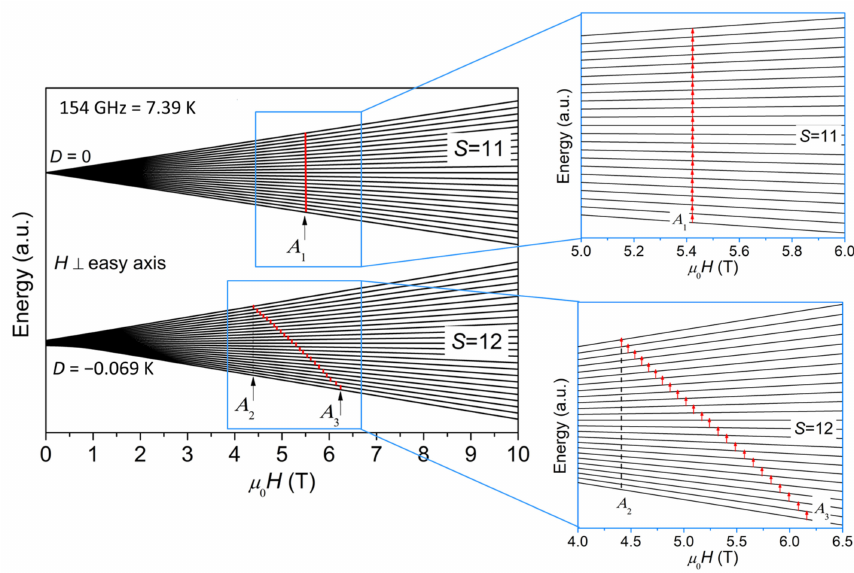
Figure 4. A schematic representation of the energy levels for S = 11 and S = 12 as a function of magnetic field ( H ⊥ easy axis), where A 1 , A 2 , and A 3 for 154 GHz are marked with arrows. The S = 11 and S = 12 quantum levels are separated for the sake of clarity. The regions where the transitions at 154 GHz occur are zoomed in and shown on the right.